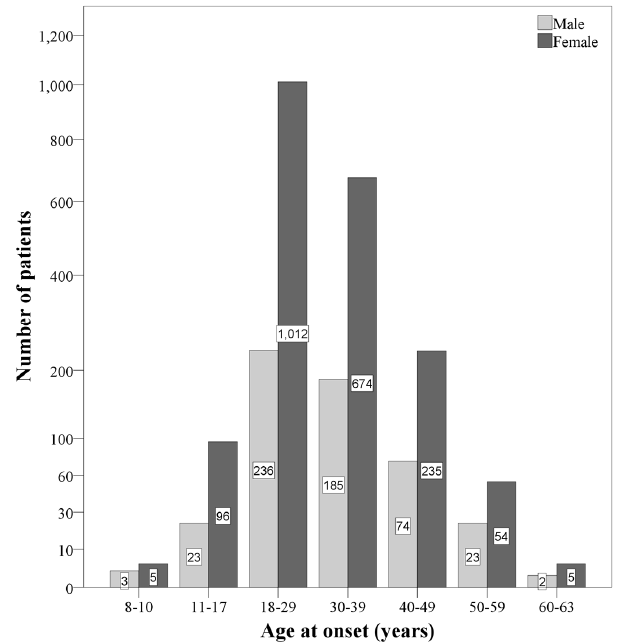
Figure 1. Overview of the distribution of participants, separately for gender and age categories. The female/male-ratios within the age categories are as follows: 8–10 years: 1.66:1; 11-17 years: 4.17:1; 18– 29 years: 4.28:1; 30–39 years: 3.64:1; 40–49 years: 3.17:1; 50–59 years: 2.34:1; 60–63 years: 2.5:1.